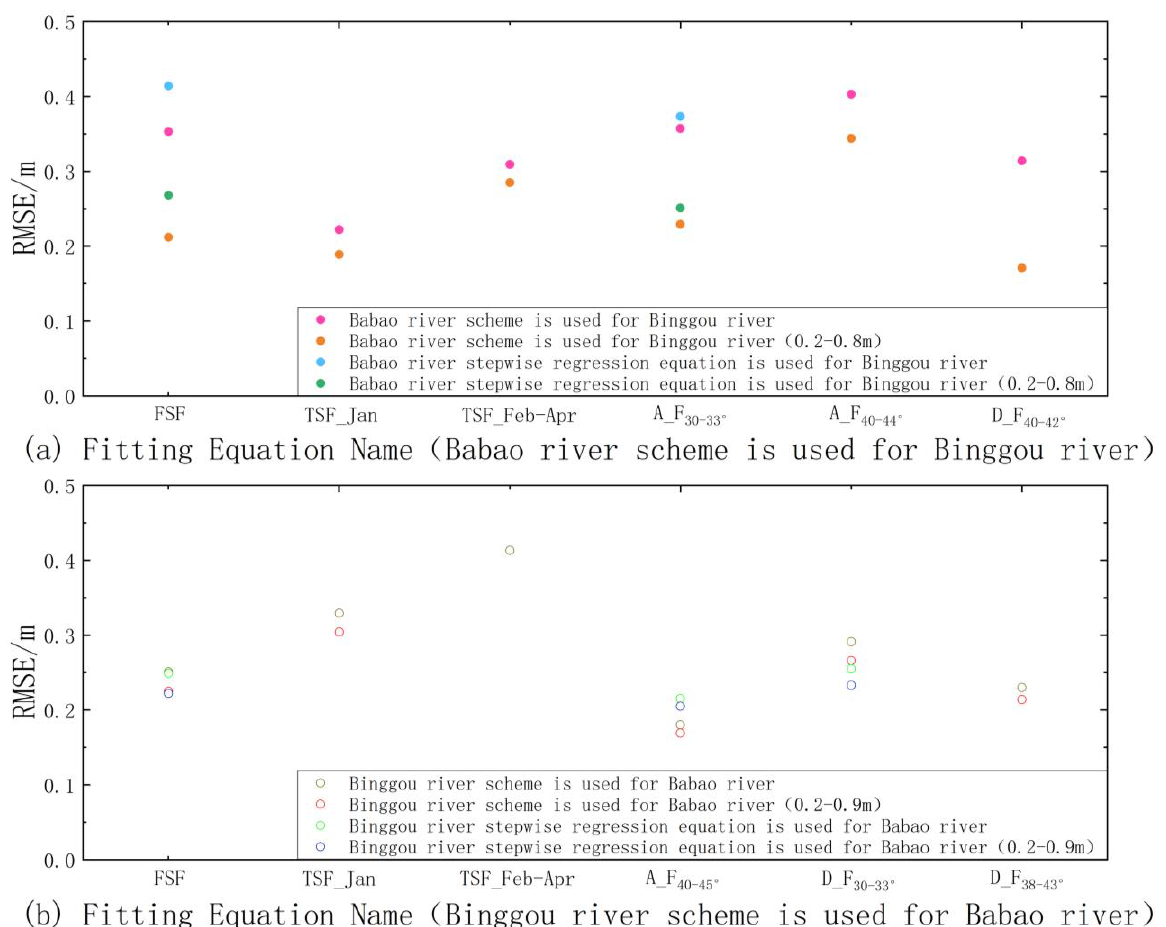
Figure 14. Comparison of the inversion accuracies obtained by applying different river-level inversion equations to the other region. The above figure shows the simulation accuracies of the equations applied to both regions; the horizontal coordinate shows the name of the fitting equation for each scheme, and the vertical coordinate is the simulation RMSE. ( a ) Babao River scheme is used for Binggou River; ( b ) Binggou River scheme is used for Babao River.